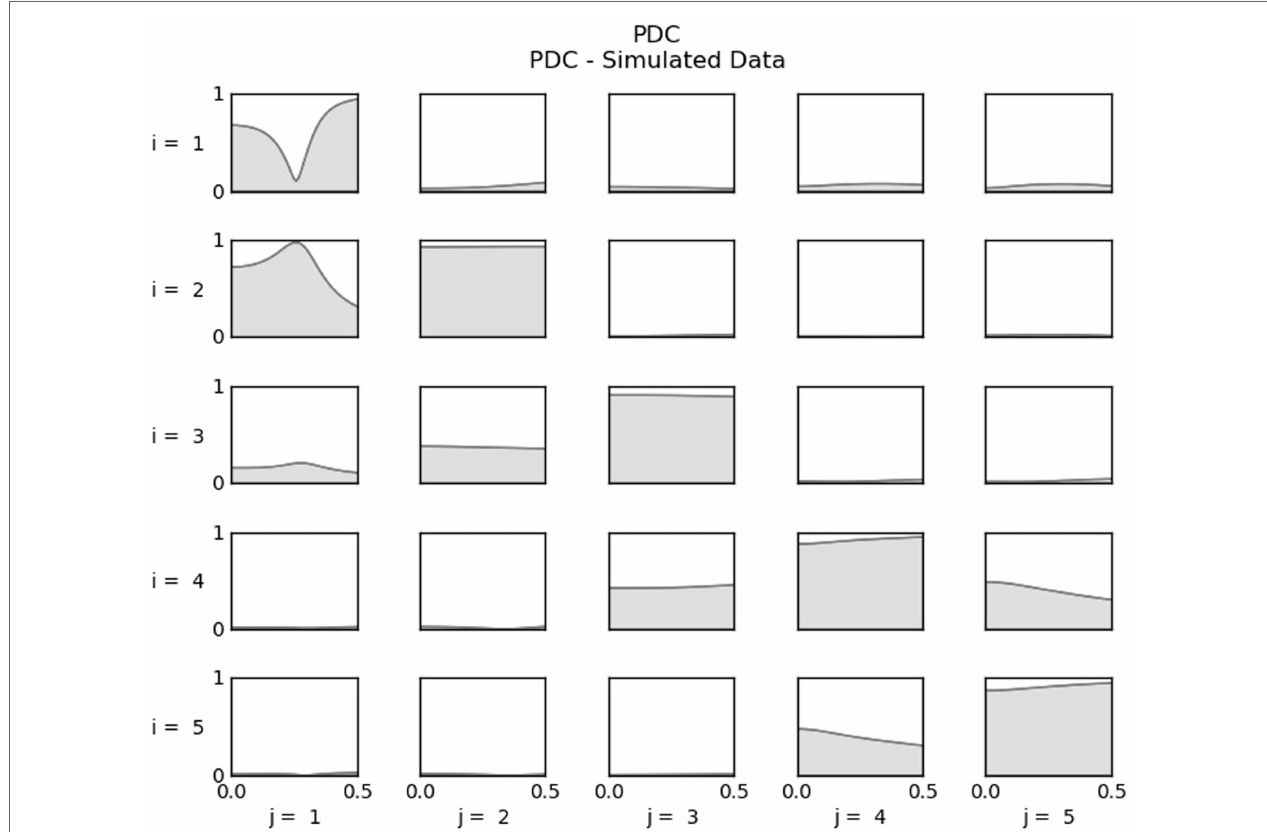
FIGURE 2 | PDC values computed from the simulated data. For each cell, the influence is from j -channel to i -channel. Thus, in the second line, the first plot shows the influence from channel one ( j = 1) to channel two ( i = 2).